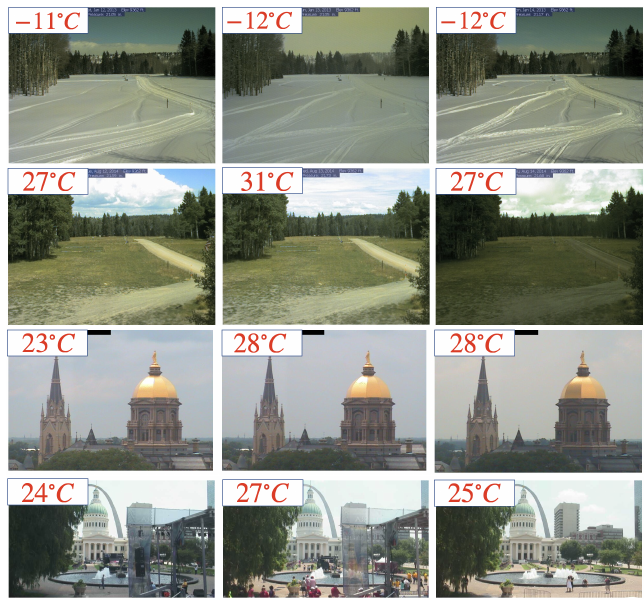
Figure 3. Sample scenes from the Glasner-Exp dataset. The first two rows correspond to the same scene in different seasons (January and